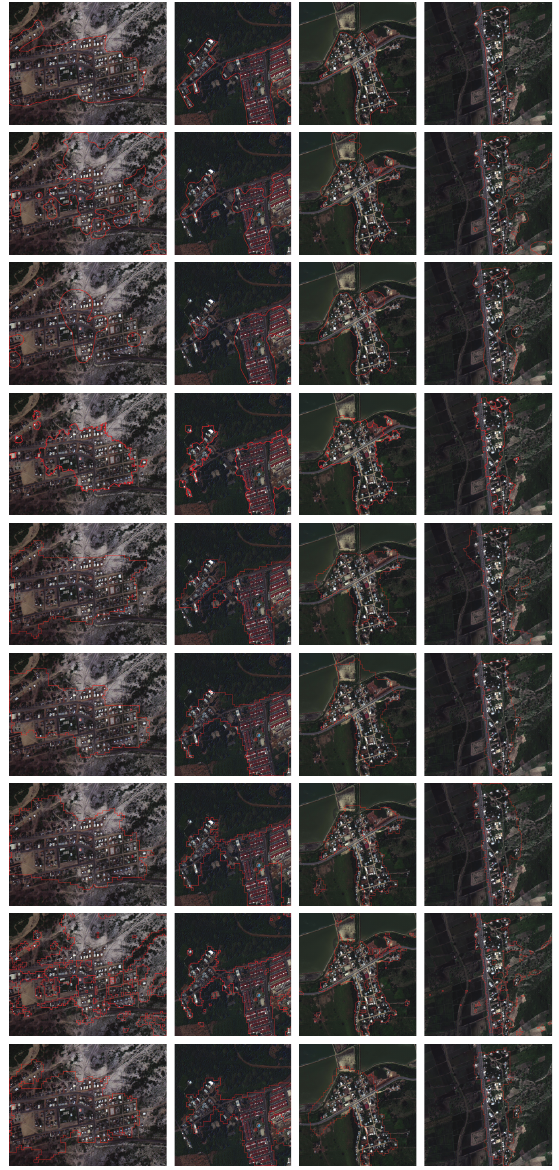
Figure 6. Qualitative illustration of different methods for urban area detection on four typical images of the DigitalGlobe dataset. From left to right: #1 image (2.417 S, 80.606 W, 0.5 m/pixel, 1352 × 1044), #5 image (1.033 N, 80.455 W, 0.5 m/pixel, 1020 × 1064), #10 image (0.633 N, 80.356 W, 0.5 m/pixel, 1336 × 1384) and #38 image (0.917 N, 80.467 W, 0.5 m/pixel, 1608 × 1532). From top to bottom: ground truth, results of the method in [13], the method in [15], the method in [16], VWRD [23], PCA + SVM, DCNNs + SVM, CNN [36] and our proposed